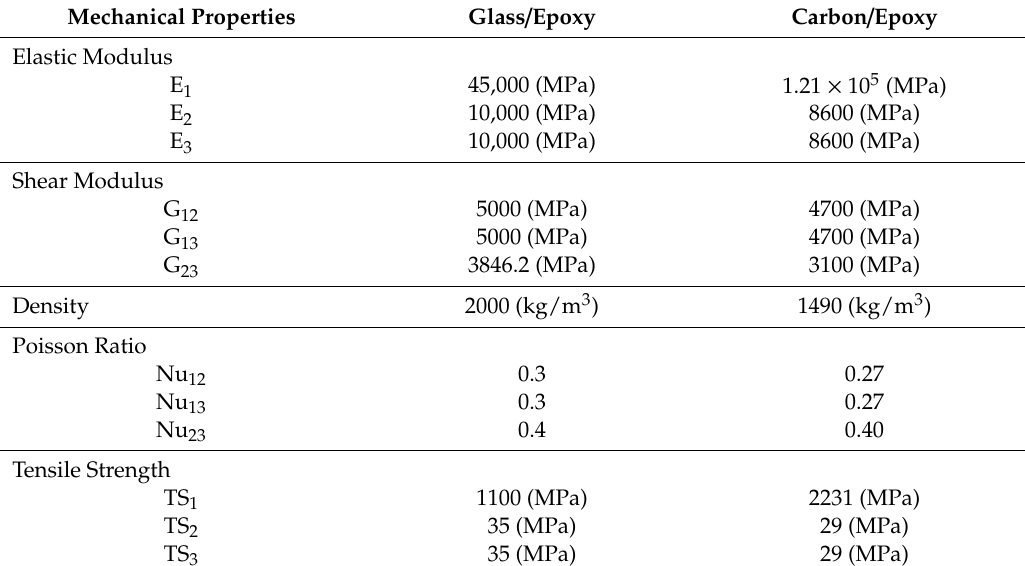
Table 1. Mechanical properties of glass / epoxy and carbon / epoxy materials